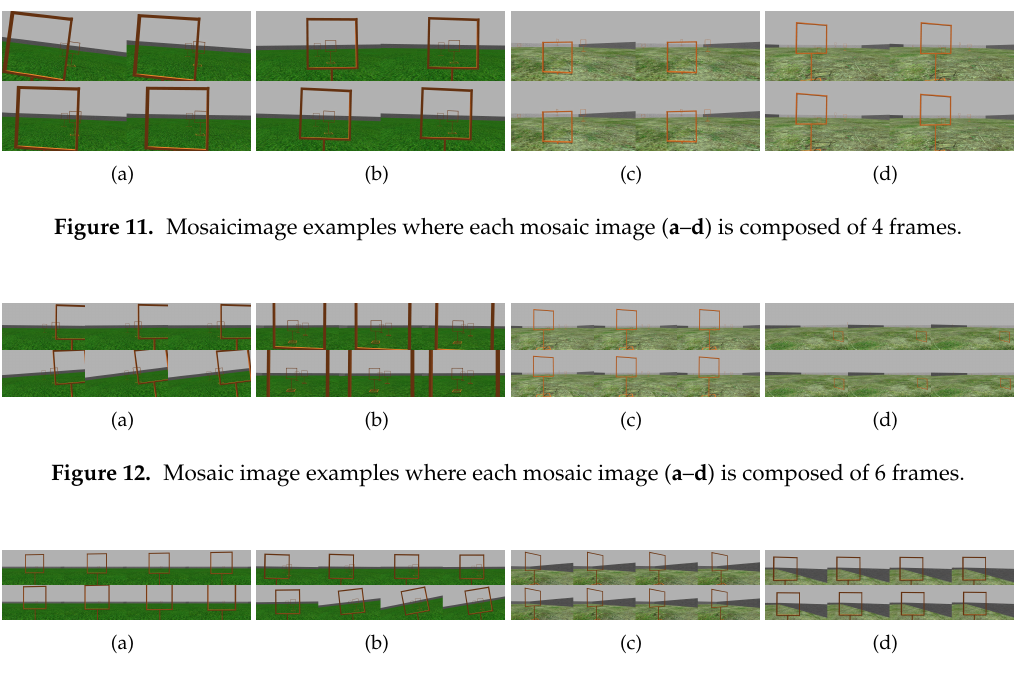
Figure 13. Mosaic image examples where each mosaic image ( a – d ) is composed of 8 frames. Table 3. Number of mosaic images in the datasets used to train the models for the flight commands ( φ , θ , ψ , h ).